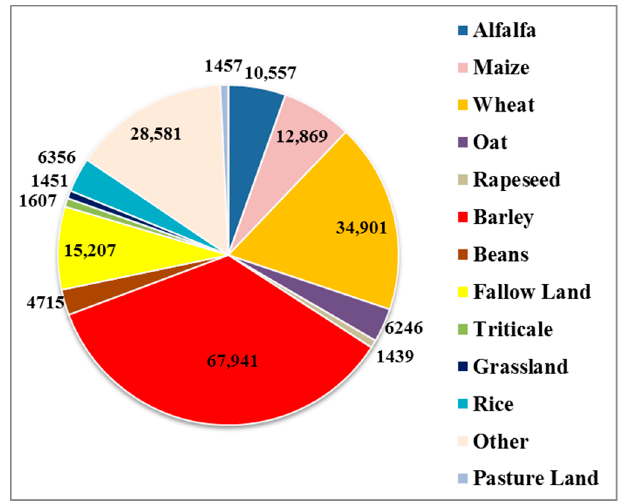
Figure 3. Distribution of the number of agricultural plots per class of crop type.